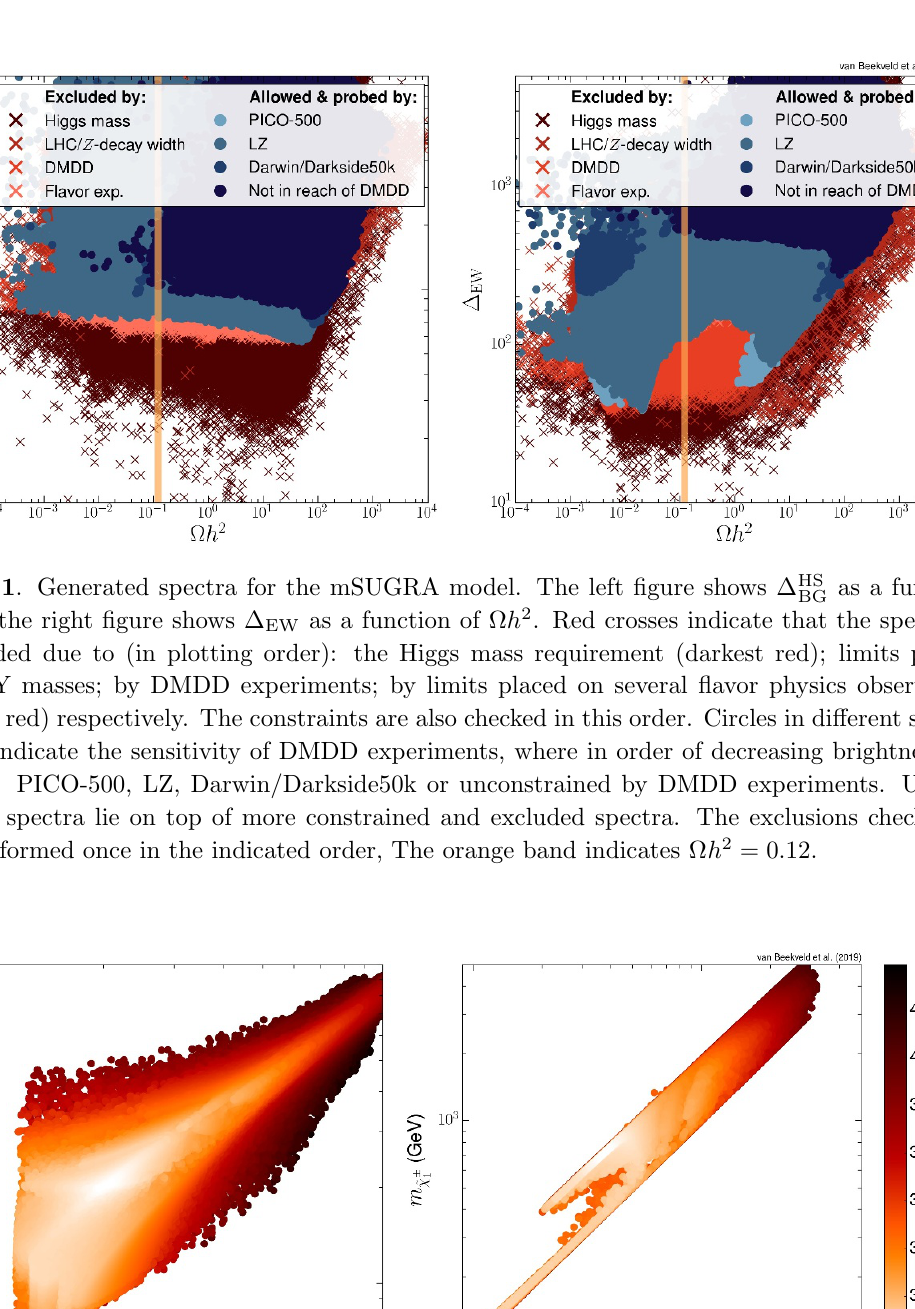
) for mSUGRA, showing t 1 ) against the lightest neutralino ~ (cid:31) (cid:6) 1 ((cid:1) HS ) lie on top of spectra 10 BG